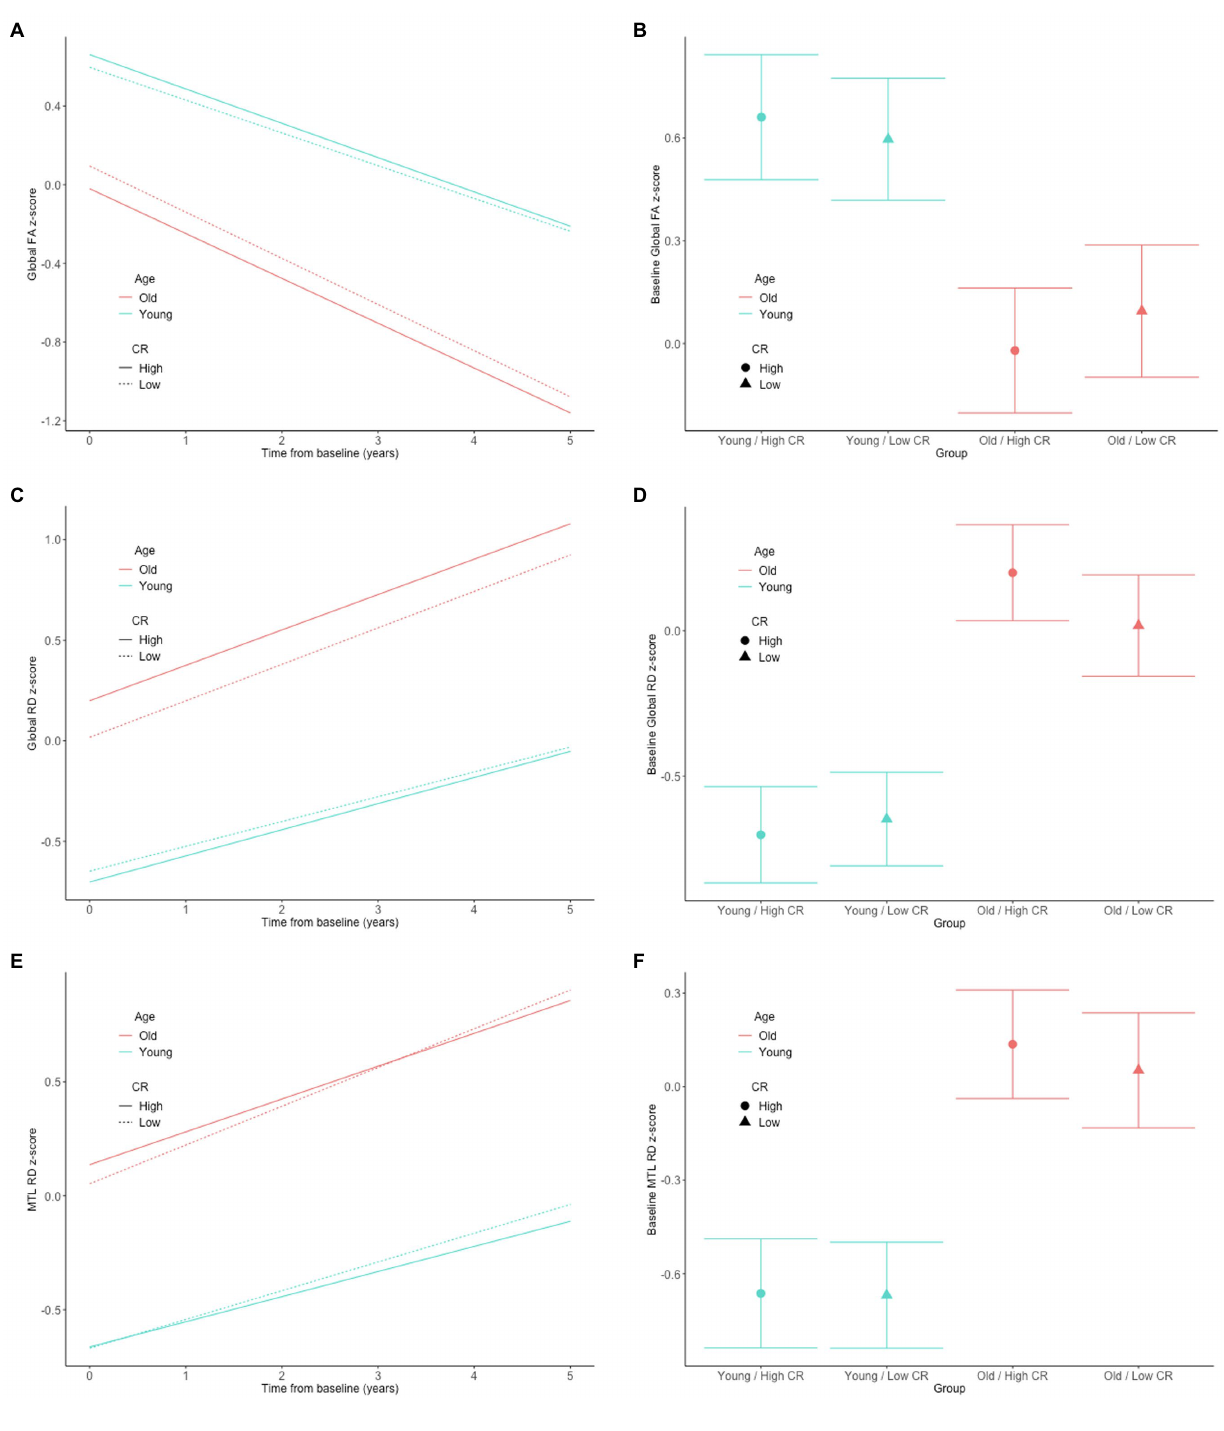
FIGURE 2 | Estimates of the association between CR composite scores and age in relationship to longitudinal change in (left) and baseline level of (right) white matter microstructure, as measured by global FA (A,B) , global RD (C,D) , and MTL RD (E,F) in the cognitively normal sample. The CR composite score and age were dichotomized by median split for illustration purposes, but treated as continuous variables in the linear mixed effects